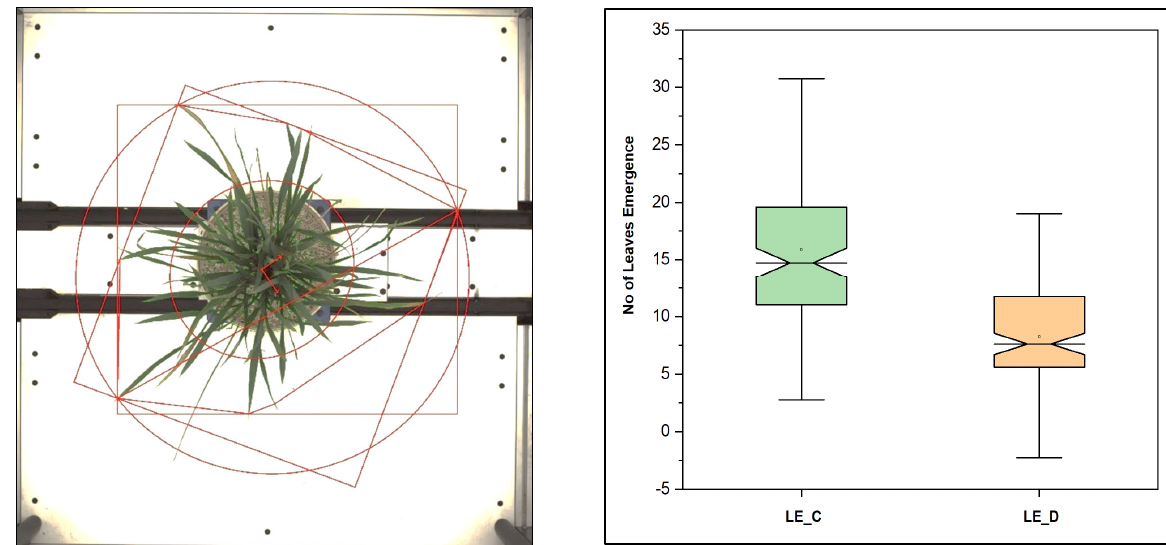
Figure 12. Different parameters, geometrical traits in the rice plant estimated from the top view, and leaf emergence in rice in control and stress, drought condition. More leaf emergence in control conditions compared to drought conditions was observed.